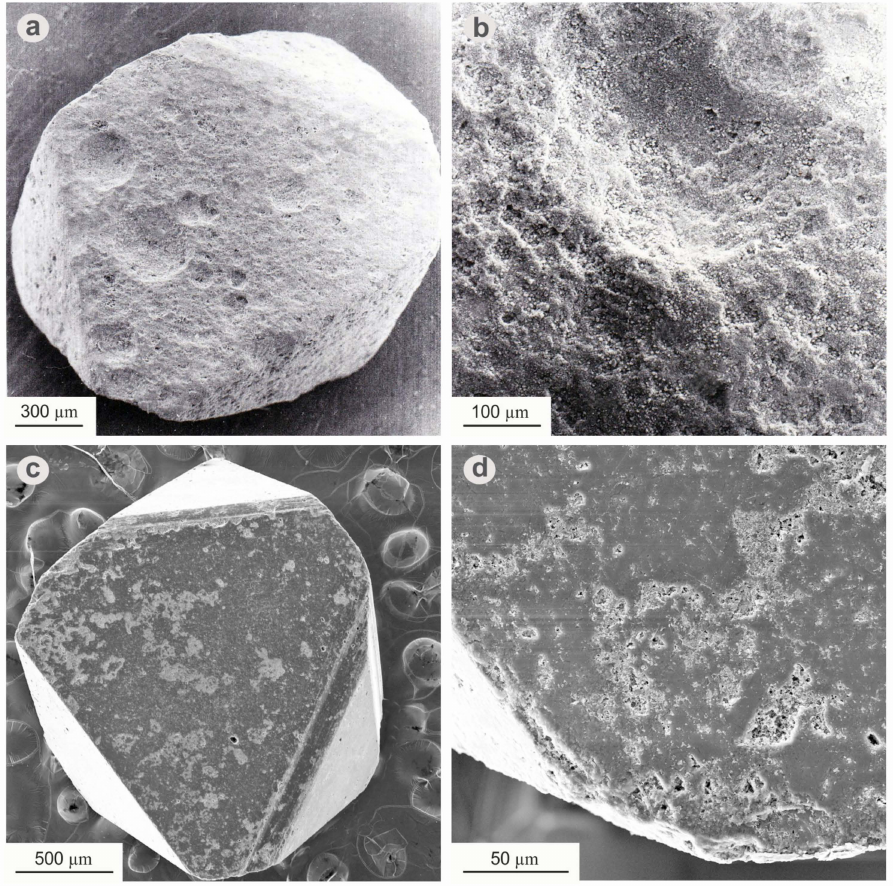
Figure 5. Diamond crystals etched in the presence of a basaltic melt, under the CCO buffer, at 1200 ◦ C for 14 h ( a , b ) and at 1000 ◦ C for 120 h ( c , d ). ( a , c ): general view; ( b , d ): fragments of an octahedral face